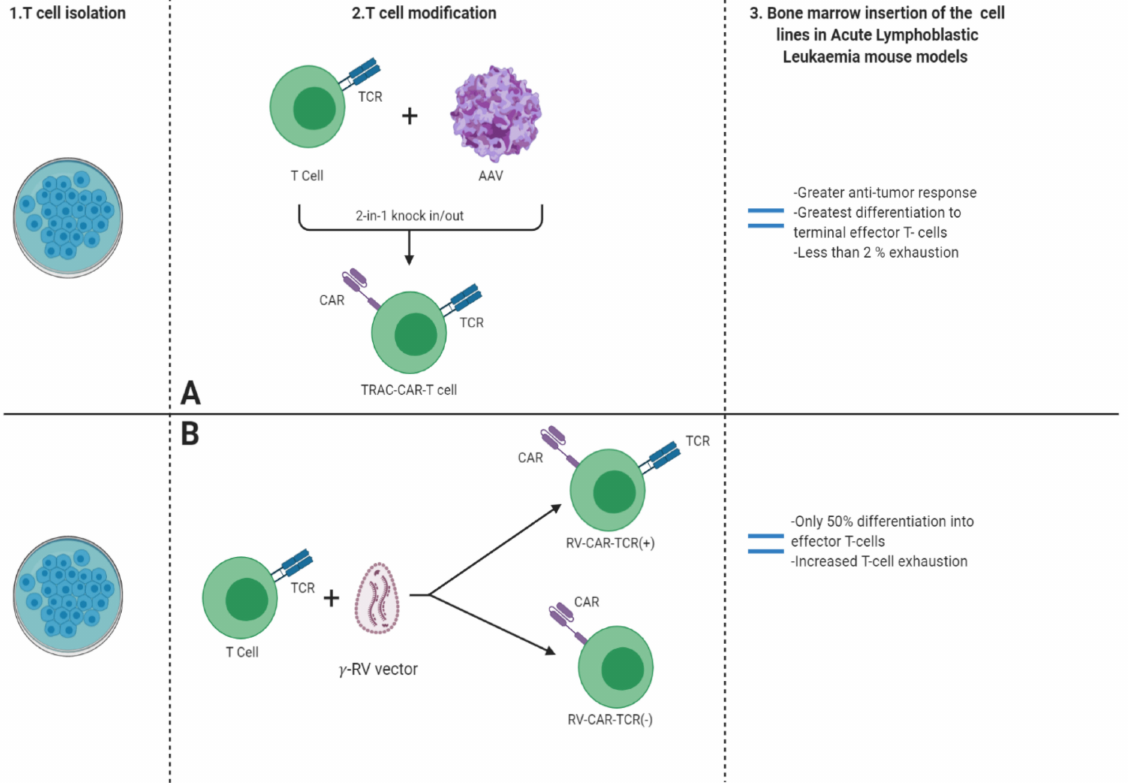
Figure 4. Firstly, T cell isolation was conducted